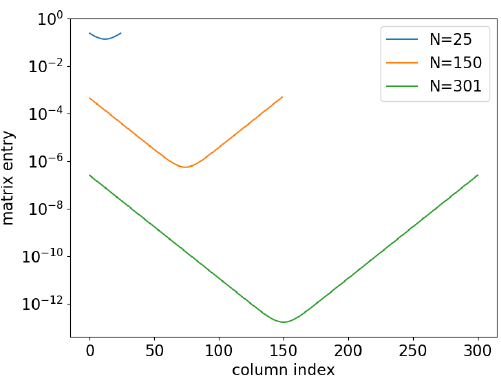
Figure B1. Difference between coefficients of row (cid:98) N/ 2 (cid:99) of matrix G and that of A − 1 for q =